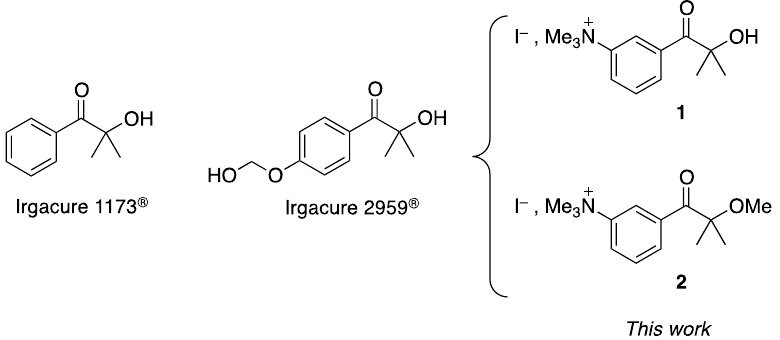
Figure 1. New proposed water-soluble PIs derived from Irgacure 1173.